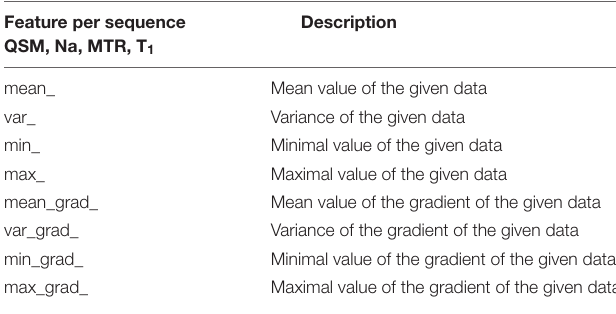
TABLE 3 | Description of features used for the random forest